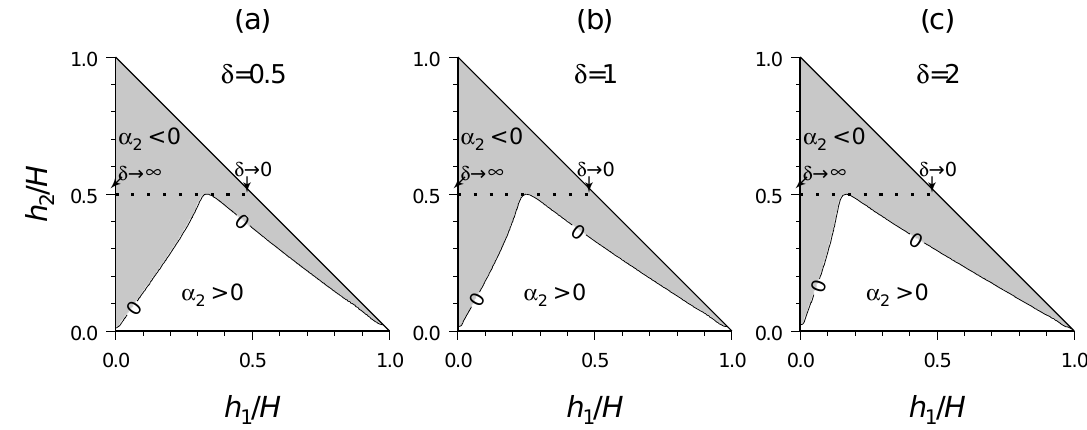
Fig. 8. The solution space for the quadratic nonlinearity coefficient as a function of layer thickness and stratification. The axes have been nondimensionalized by the vertical length scale H (depth). The impact of changing stratification is shown by plotting graphs for different values of the stratification parameter, namely δ = 1ρ 1 /1ρ 2 = 0 . 5, 1.0, and 2.0 in panels (a) , (b) , and (c) , respectively. Shaded areas show negative values. The dashed lines represent the envelope when α 2 =